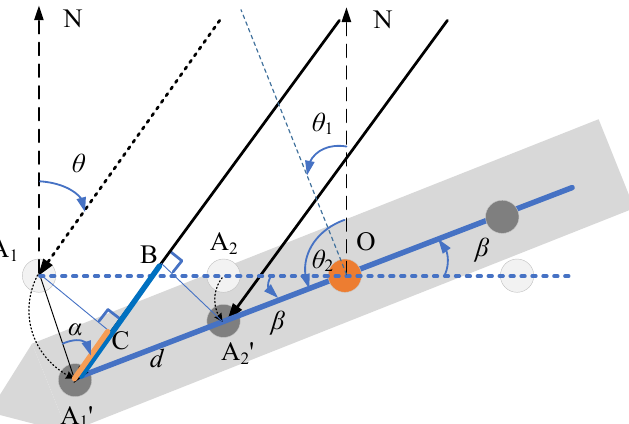
Figure 3. The physical model of the shipborne HFSWR platform in case of heading changing during the navigation.